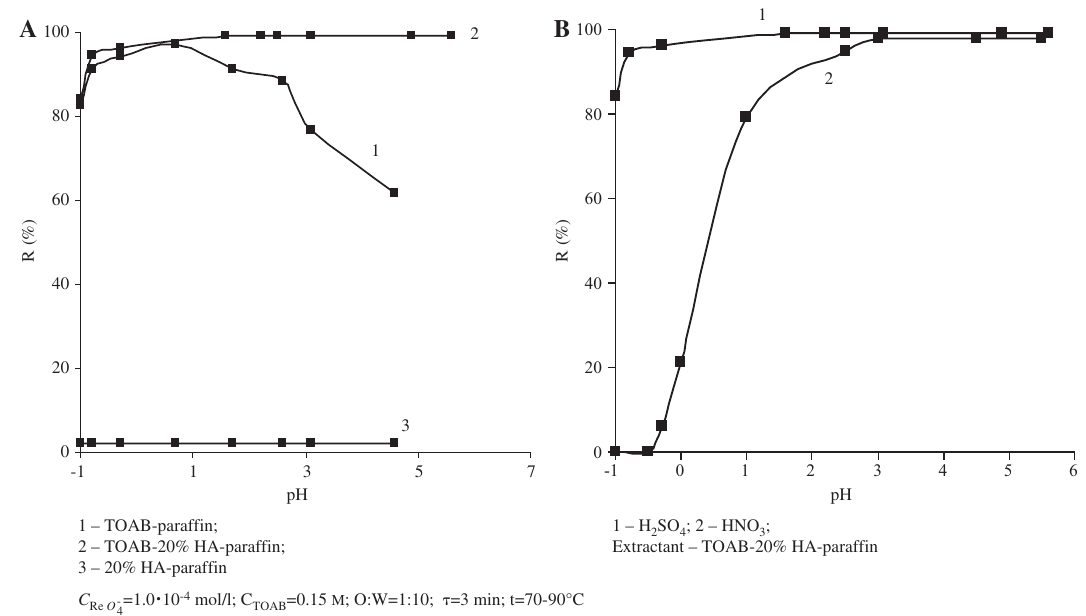
Figure 1 Dependence of the degree of extraction of Re (VII) on the acidity of the aqueous phase.